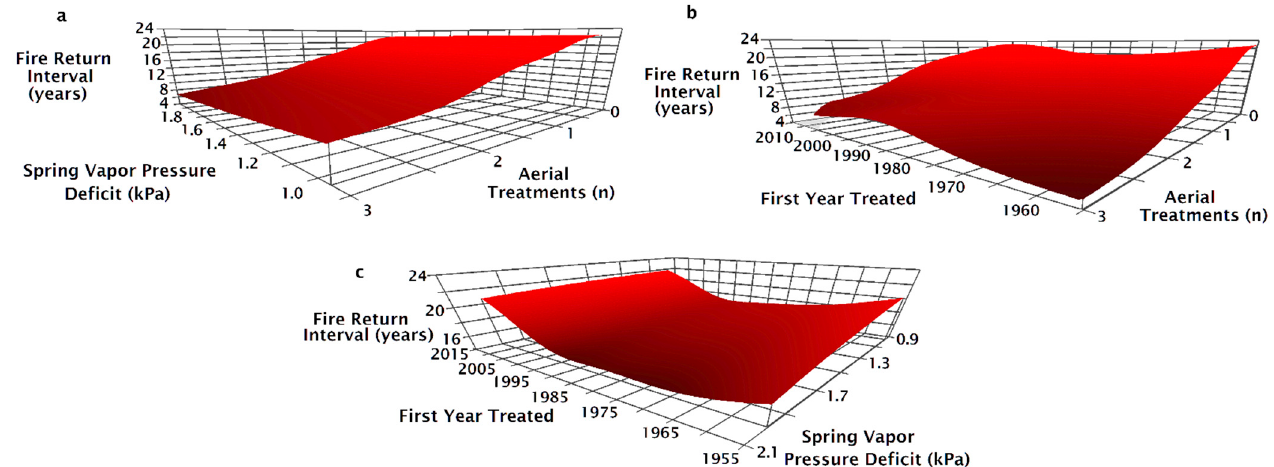
Figure 5. The Nonparametric Multiplicative Regression modeled relationship response of fire return interval (FRI) to ( a ) the number of aerial seeding treatments and the 30-year average minimum vapor pressure deficit in spring (spring VPD), ( b ) the first year a site had a seeding treatment and the number of aerial seeding treatments, ( c ) the first year a site had a seeding treatment and the spring VPD. The color scale ranges from shorter FRIs (black) to longer FRIs (gray). Unshaded areas in the predictor space represent areas where predictor variable data was insufficient to model the relationship.